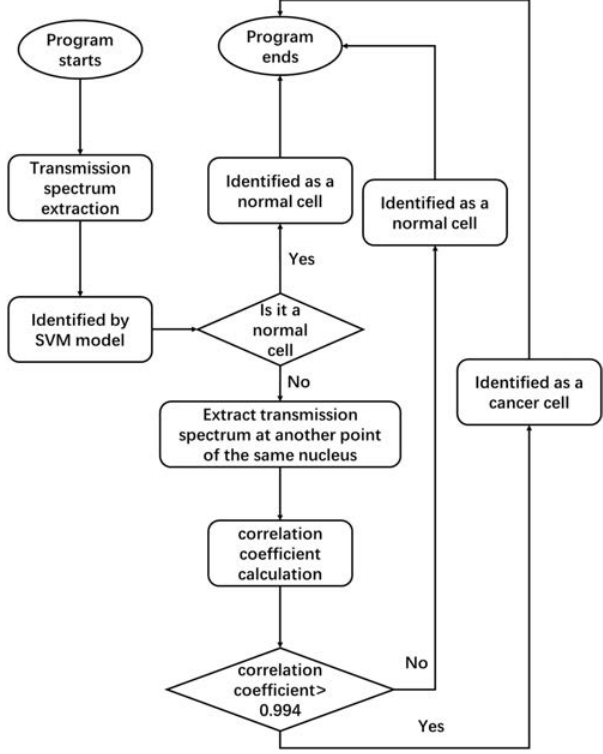
Fig. 5. Flowchart of program used to correct classi¯cation model.